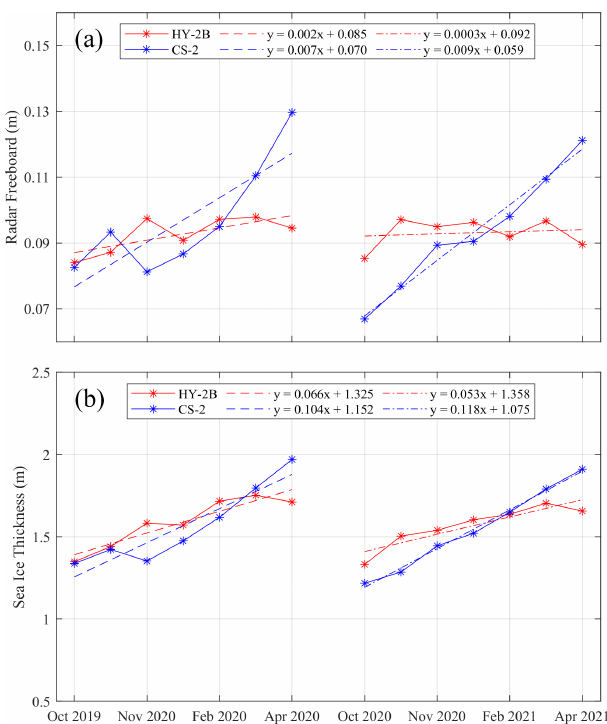
Figure 7. Seasonal variation trends of HY-2B and CryoSat-2 radar and from October 2020 to April 2021. (a) Radar freeboard and (b) sea ice thickness; HY-2B: red, CS-2: blue.